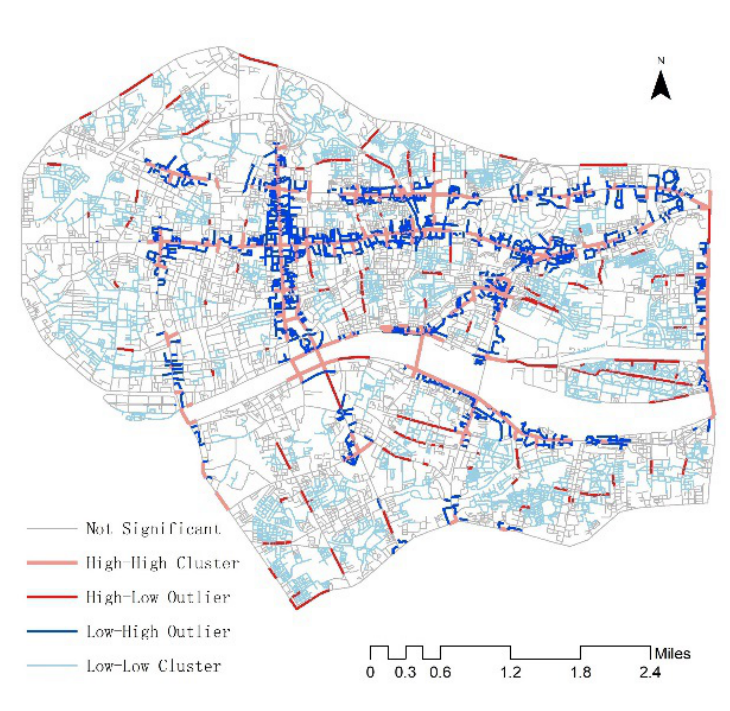
Fig. 30 Analysis of local Moran’s I of